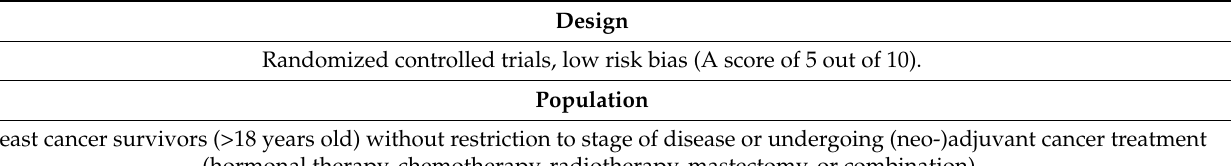
Table 1. Inclusion criteria according to PICO